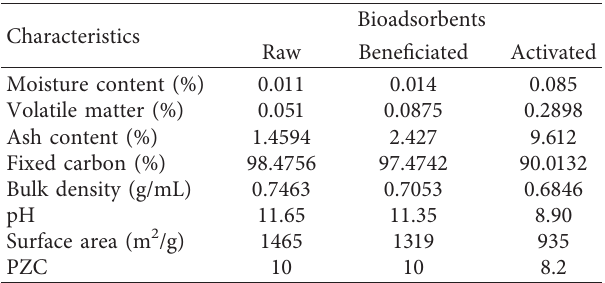
Table 1: Characteristics of raw, beneficiated, and activated waste ash